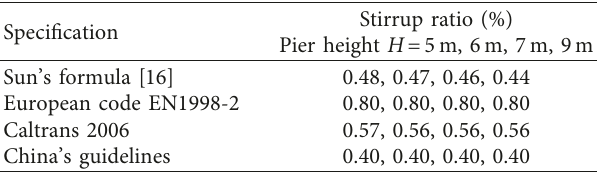
Table 5: Comparison of the stirrup ratio.